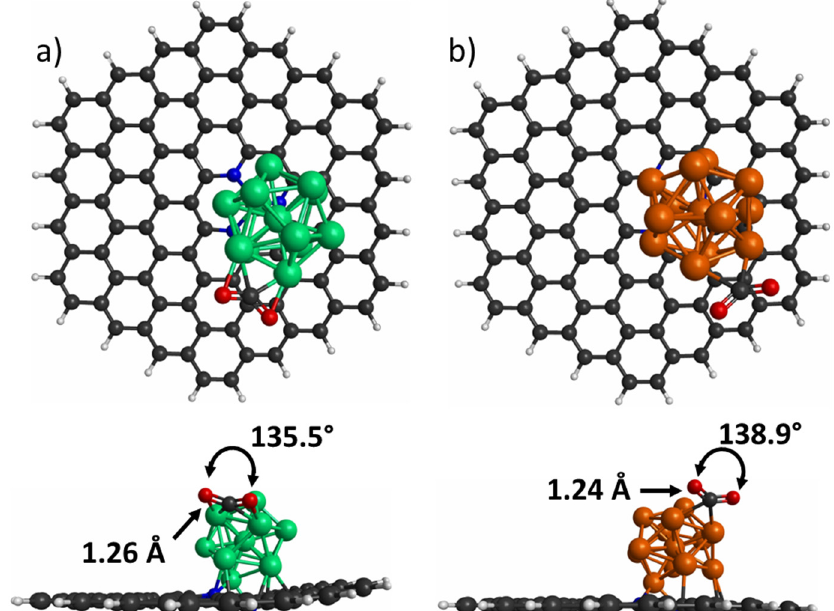
Figure 6. CO 2 adsorption on ( a ) Co 13 /PNG and ( b ) Cu 13 /PNG. The bond length (Å) and angle bending (°) of CO 2 molecule is depicted. Green, orange, black, white, blue, and red spheres represent Co, Cu, C, H, N, and O atoms, respectively. Table 2. Charge transfer from Co 13 , Cu 13 , Co 13 /PNG, and Cu 13 /PNG to CO 2 molecule. The negative values indicate charge transfers from the nanoclusters and nanoclusters/PNG to the CO 2